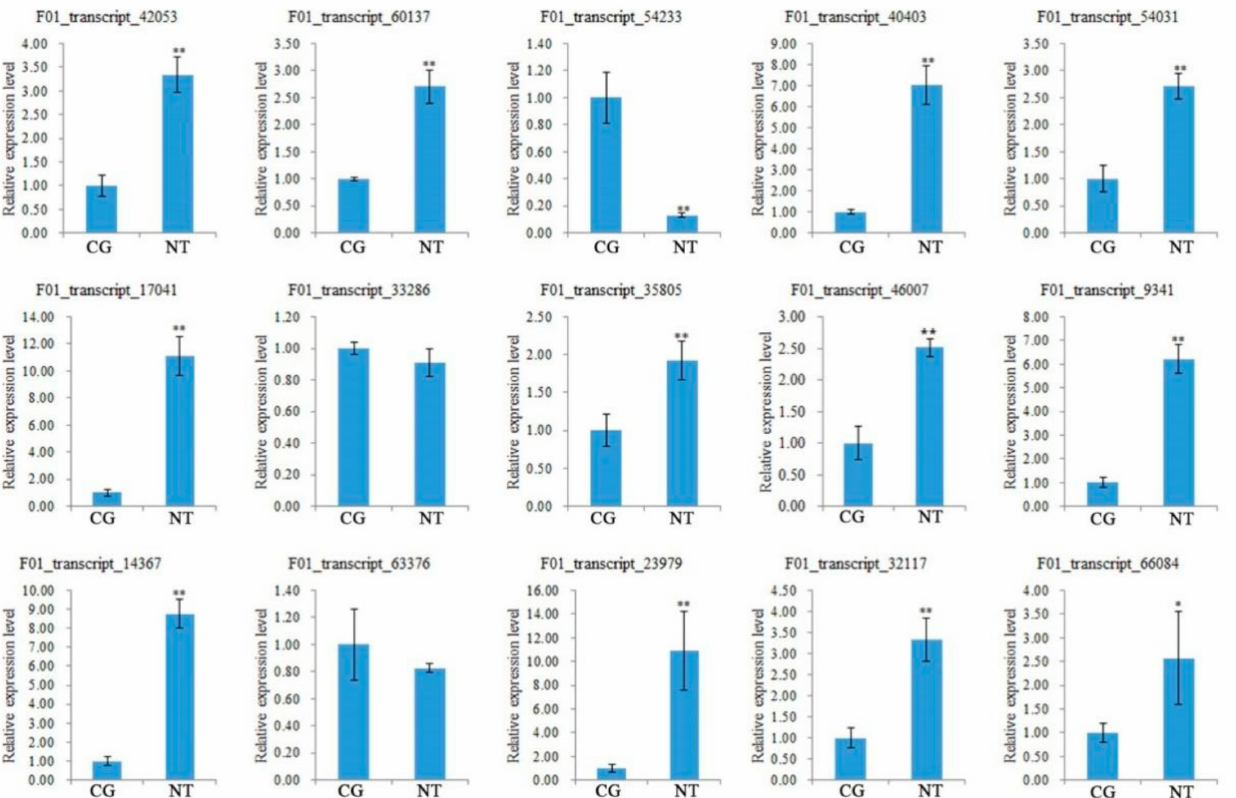
Figure 7. RT-qPCR analyses of DEGs related to R. glutinosa tuberous root quality and yield. *, ** indicate significance at p ≤ 0.05, p ≤ 0.01, respectively. F01_transcript_42053 and F01_transcript_9341 (Pro- tein ethylene insensitive3), F01_transcript_60137 and F01_transcript_40403 (Protein phosphatase 2C), F01_transcript_54031 and F01_transcript_17041 (Protein BZR1 homolog1), F01_transcript_33286 (4- coumarate-CoA ligase 2), F01_transcript_46007 and F01_transcript_35805 (Auxin-regulated gene in- (Beta-glucosidase), F01_transcript_63376 (lipoxygenase), F01_transcript_23979 (F-box protein GID2), and F01_transcript_32117 and F01_transcript_66084 (Allantoinase). To sum up, the regulation mechanism of NAA-improving yield and NAA-affecting metabolites of R. glutinosa is the following (Figure